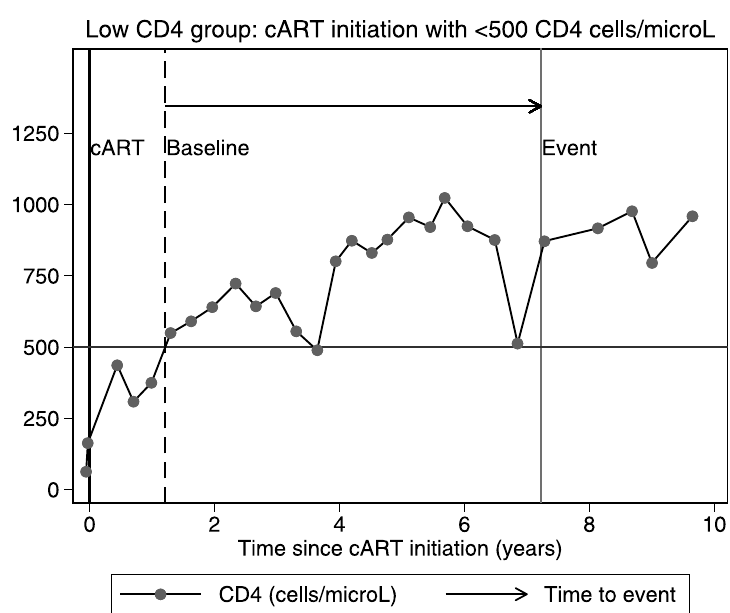
chronic herpes simplex infection. Serious AIDS events within the first 3 months after ART